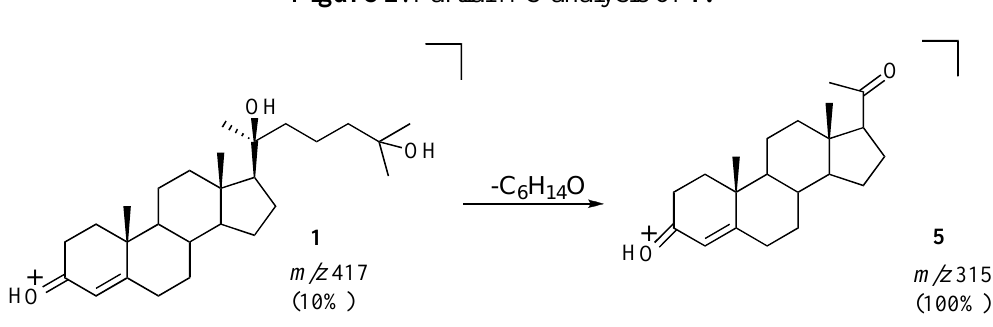
Figure 2 . Partial MS analysis of